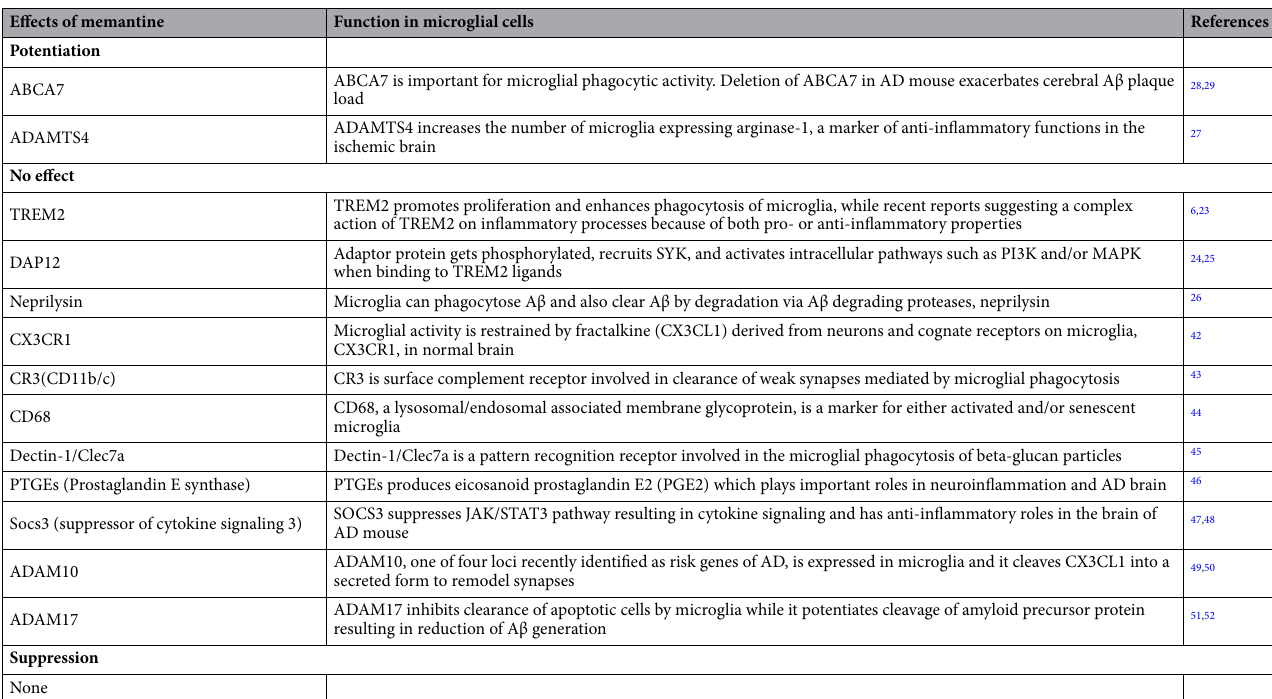
Table 1. Effects of pretreatment with memantine on the expression of phagocytosis-related proteins in mouse 6–3 microglial cells measured using flow